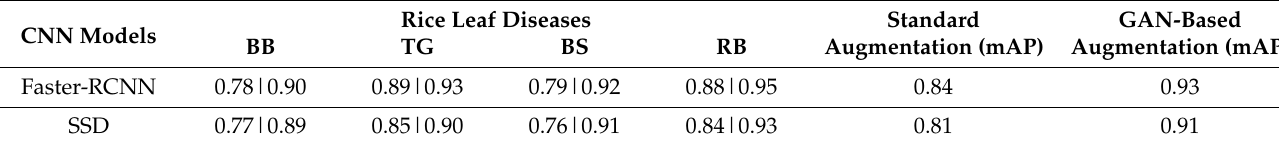
Table 3. Results of the proposed GAN-based augmentation pipeline generative